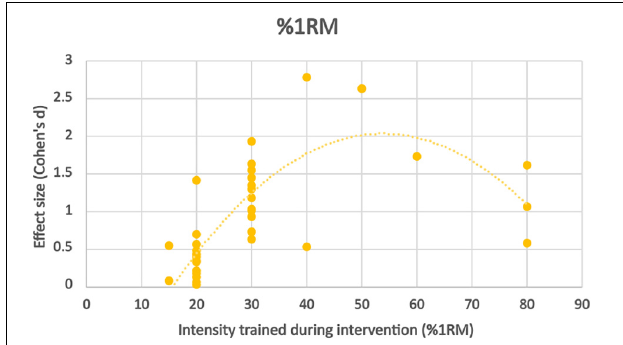
FIGURE 4 | Effect size observed at different%1RM trained during BFR exercise intervention with trendline.